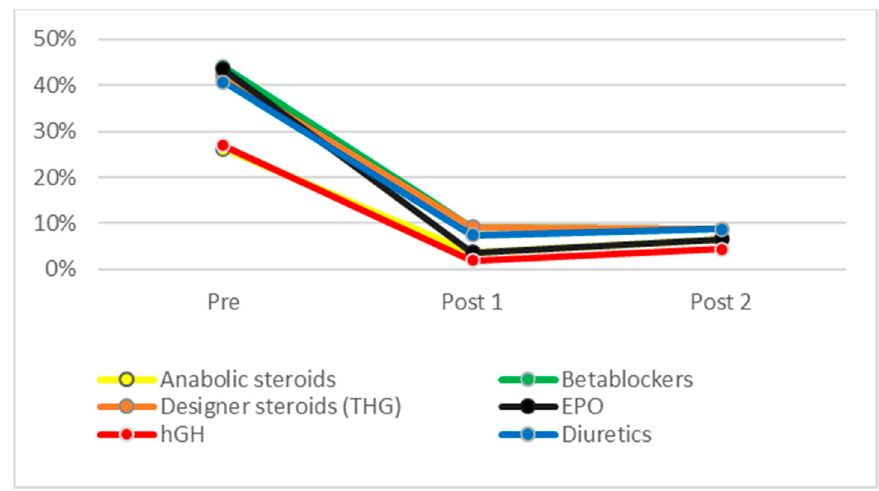
Figure 1. General ignorance about PES use on performance.